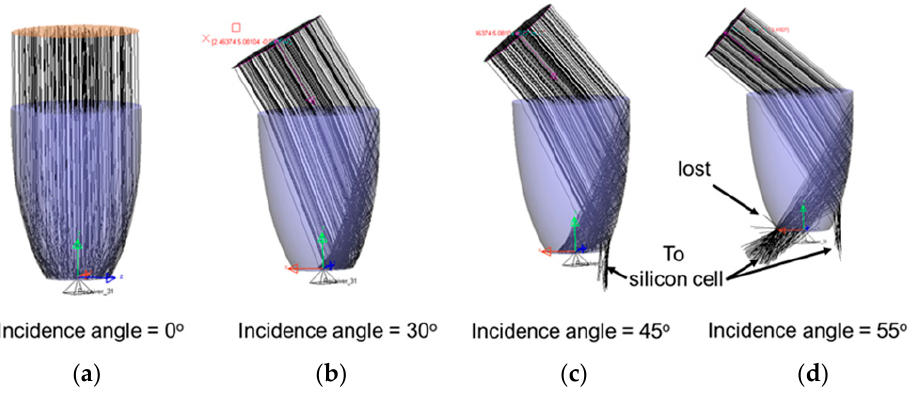
Figure 4. A ray-tracing simulation model for the solid CPC with a concentration of 4 under different incidence angles. ( a ) Incidence angle = 0°, ( b ) incidence angle = 30°, ( c ) incidence angle = 45°, and ( d ) incidence angle = 55°.